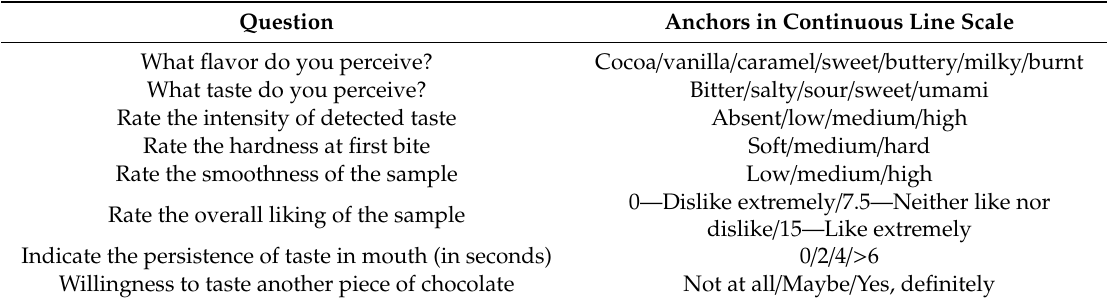
Table 2. Questions for self-reported responses and given answer